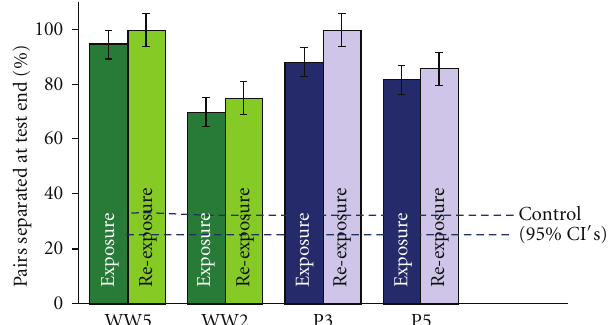
Figure 4: Proportion of pairs separated at two-hour test end ( ± SE). Wash water exposures (WW5 and WW2) are shown as green, and PEITC exposures (P3 and P5) are shown as blue. The 95% upper and lower confidence intervals for the initial control exposures are shown as dotted lines for comparative purposes.